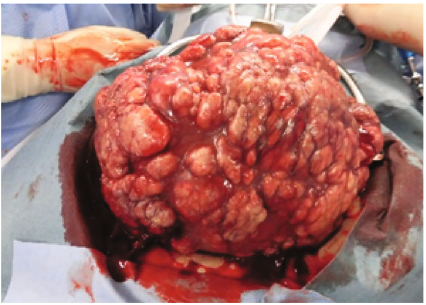
Figure 3: Macroscopic fi nding during surgery. Large di ff use nodular disseminated tumors were noted on the serosal surface of the